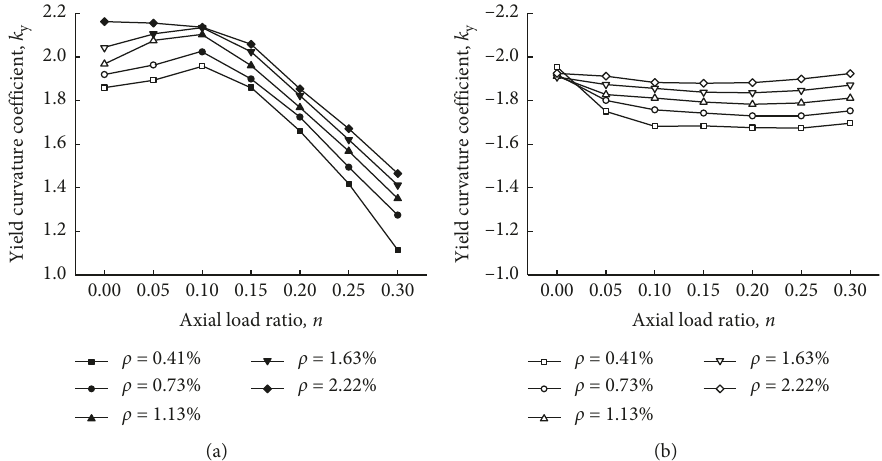
Figure 6: Variations in the yield curvature coefficient with the axial load ratio at different boundary longitudinal reinforcement ratios. (a) Flange in tension. (b) Flange in